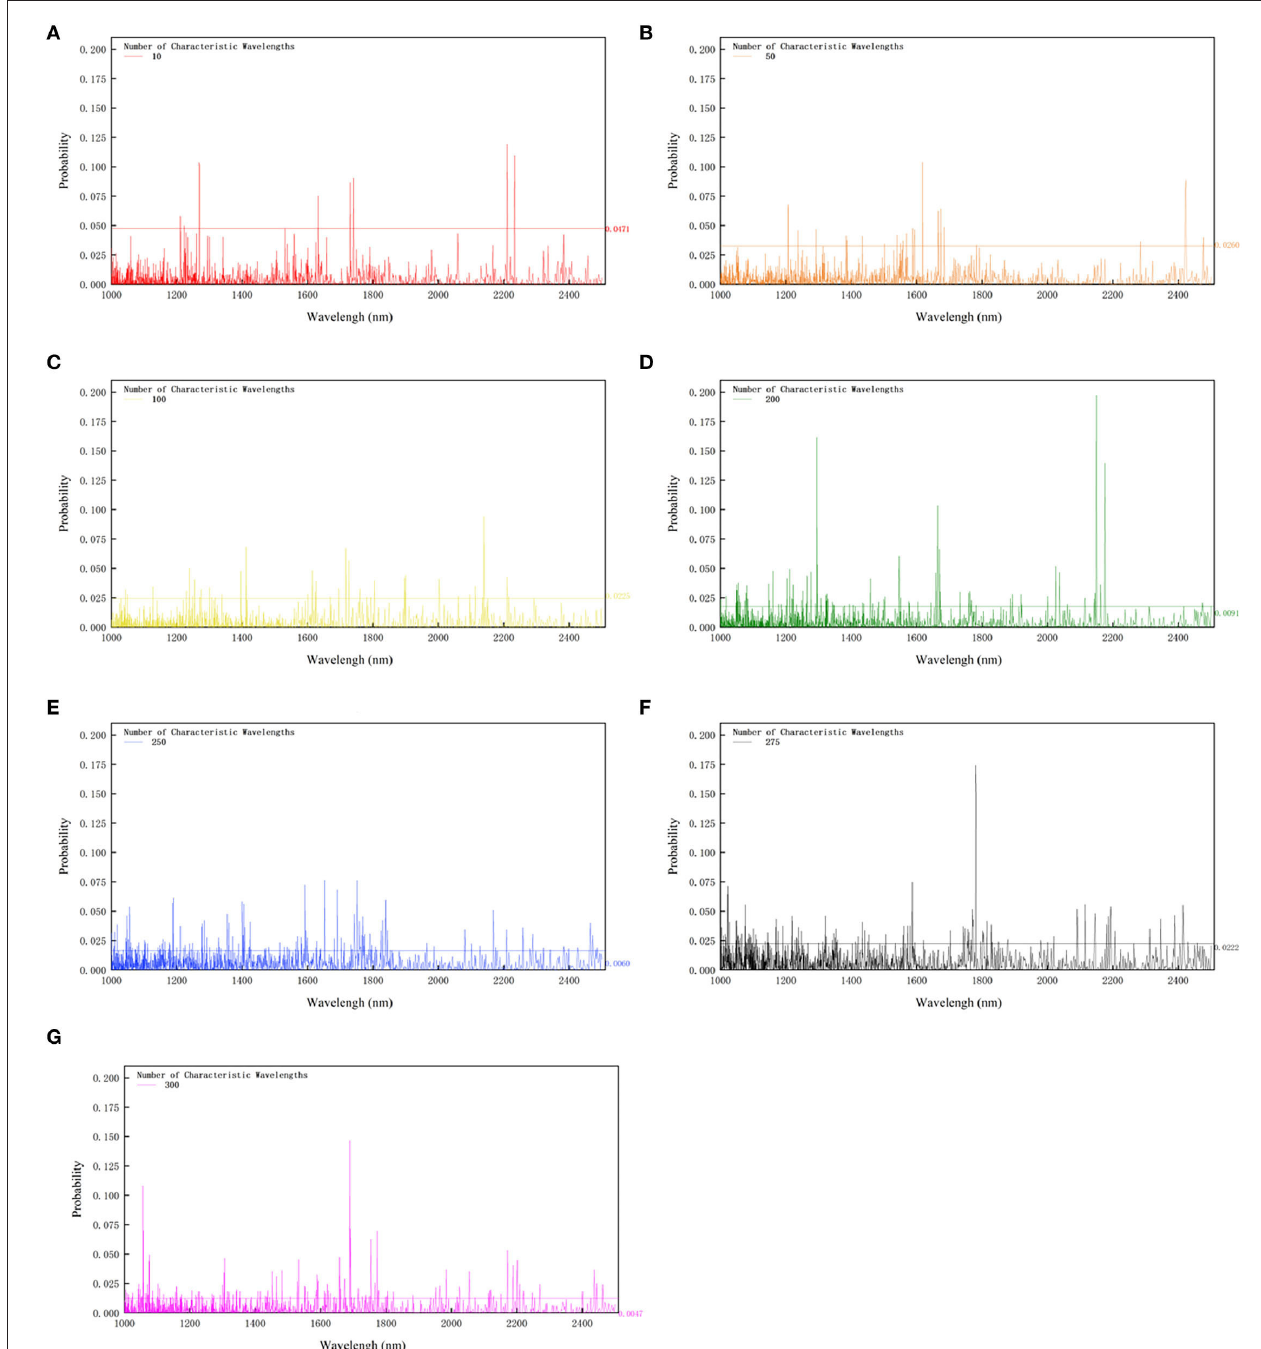
FIGURE 2 | Cutoff probability of different characteristic wavelengths. For the subsequent modeling, 10 (A) , 50 (B) , 100 (C) , 200 (D) , 250 (E) , 275 (F) , and 300 (G) characteristic wavelengths are chosen, respectively. The numbers on the right corner of the figure are the cutoff probability of corresponding characteristic wavelengths number. The cutoff probability generally decreases as the number of informative wavelengths increases.